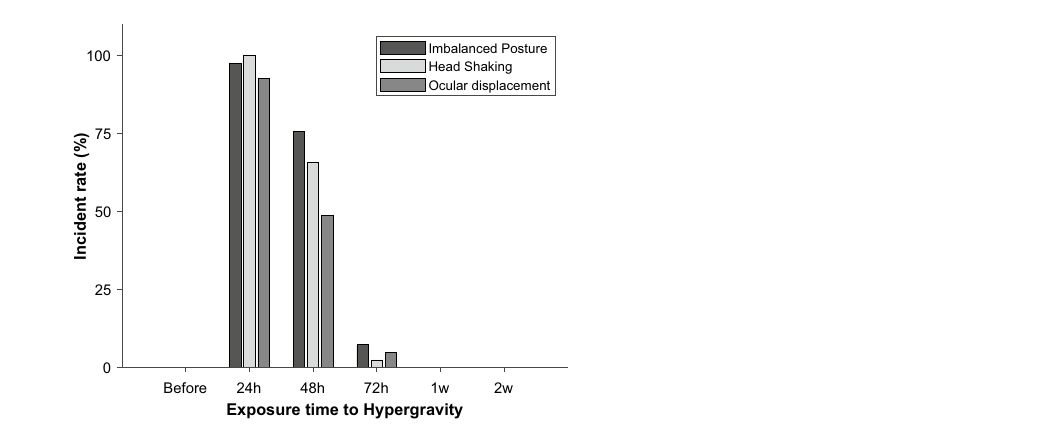
Figure 3. Correlation between the mean inter-spike interval and its coefficient of variance for the recorded neuronal firing regularity ( A ), the comparison of the averaged firing rates ( B ), and the gains of the neuronal responses to head acceleration among the different groups ( C ). In both static ( B ) and dynamic neuronal parameters ( C ), no statistical significance was observed.